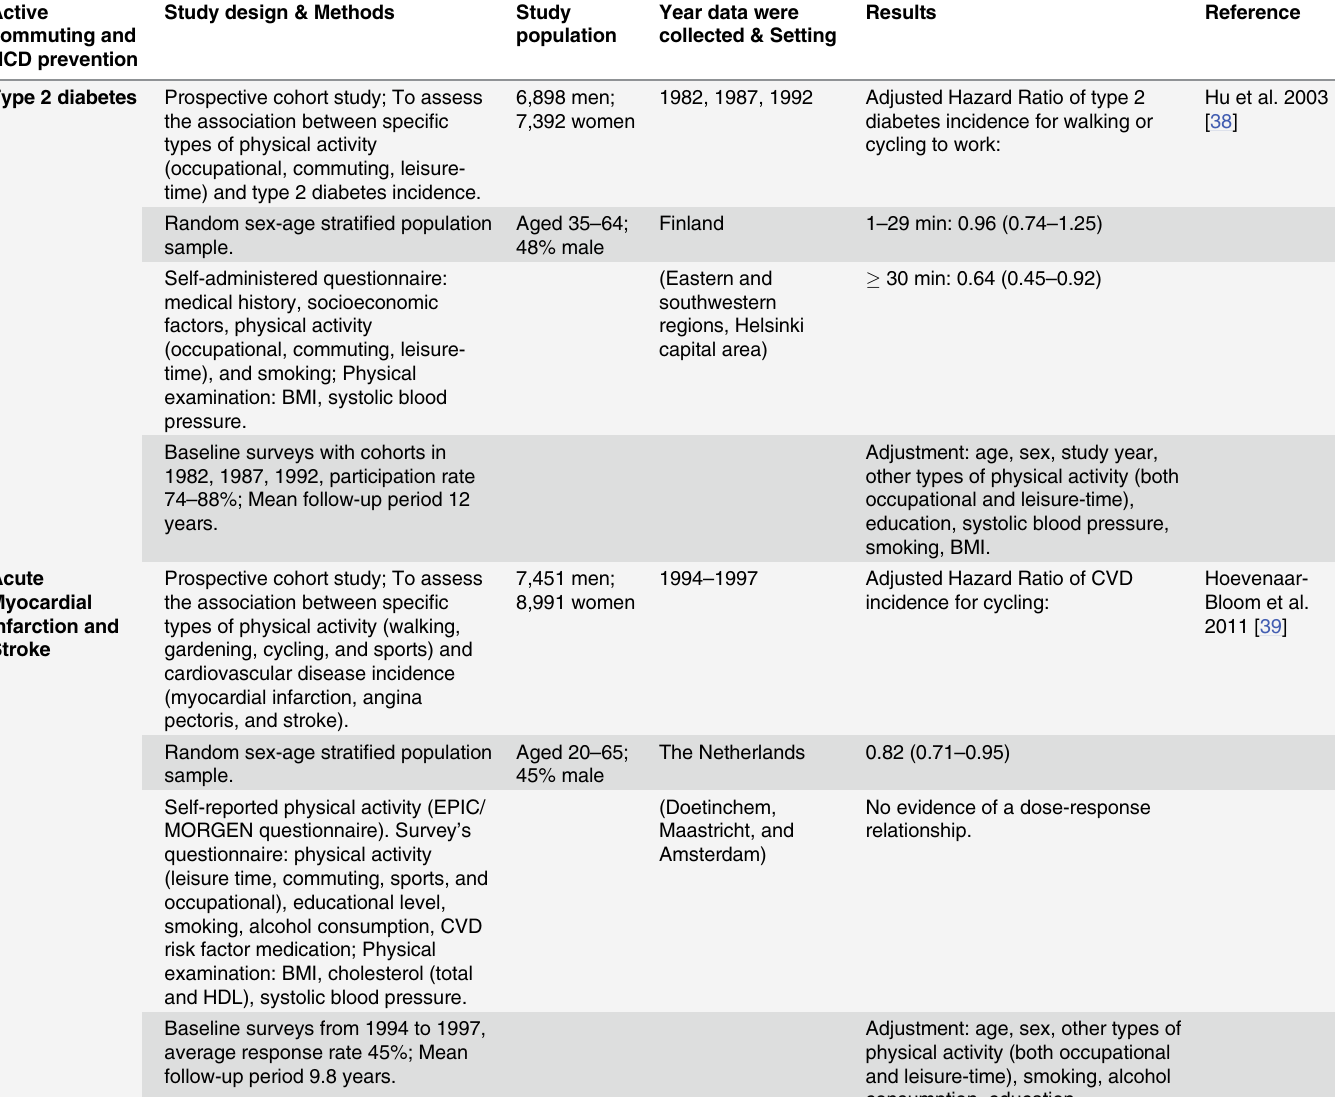
Table 2. Literature data: Active commuting and NCD